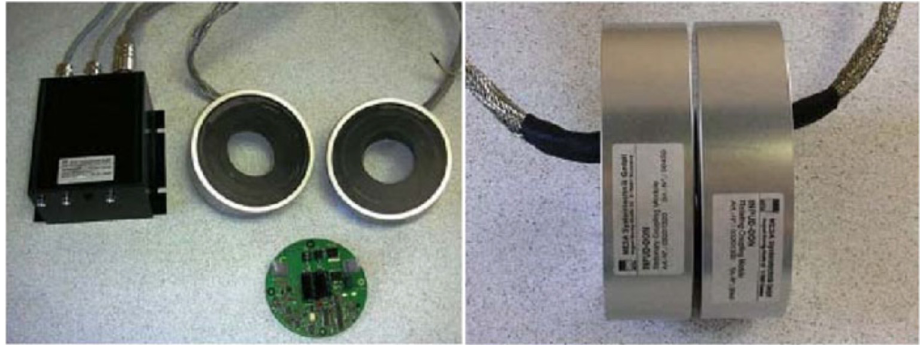
Figure 25. INPUD DON100 HE30 Underwater equipment [136].